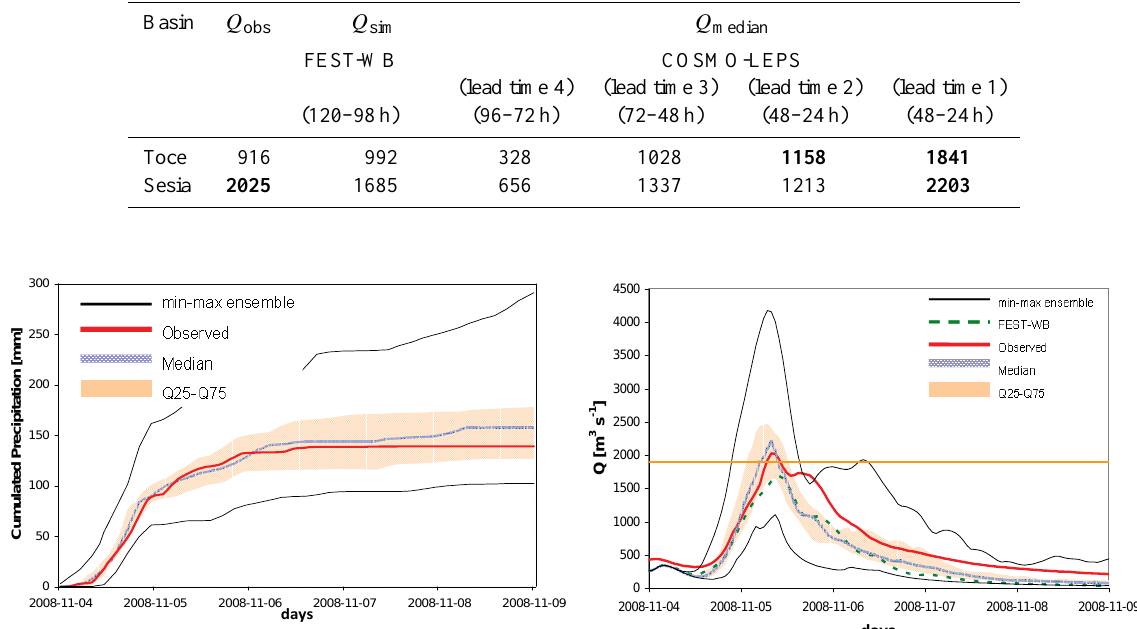
Table 3. Comparison between observed data and simulated peak discharge values [ Q in m 3 s − 1 ] with the FEST-WB model driven by measured data and the COSMO-LEPS forcings at different lead times; values exceeding alert code 2 are shown in bold. The Q median shows the median value of discharge forecasts at different lead times (hours before the main peak flow).